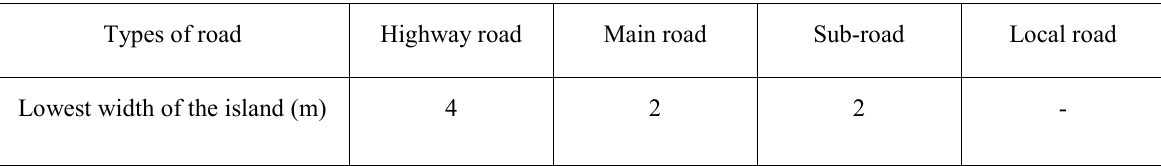
Table 4. Central part width of the different roads